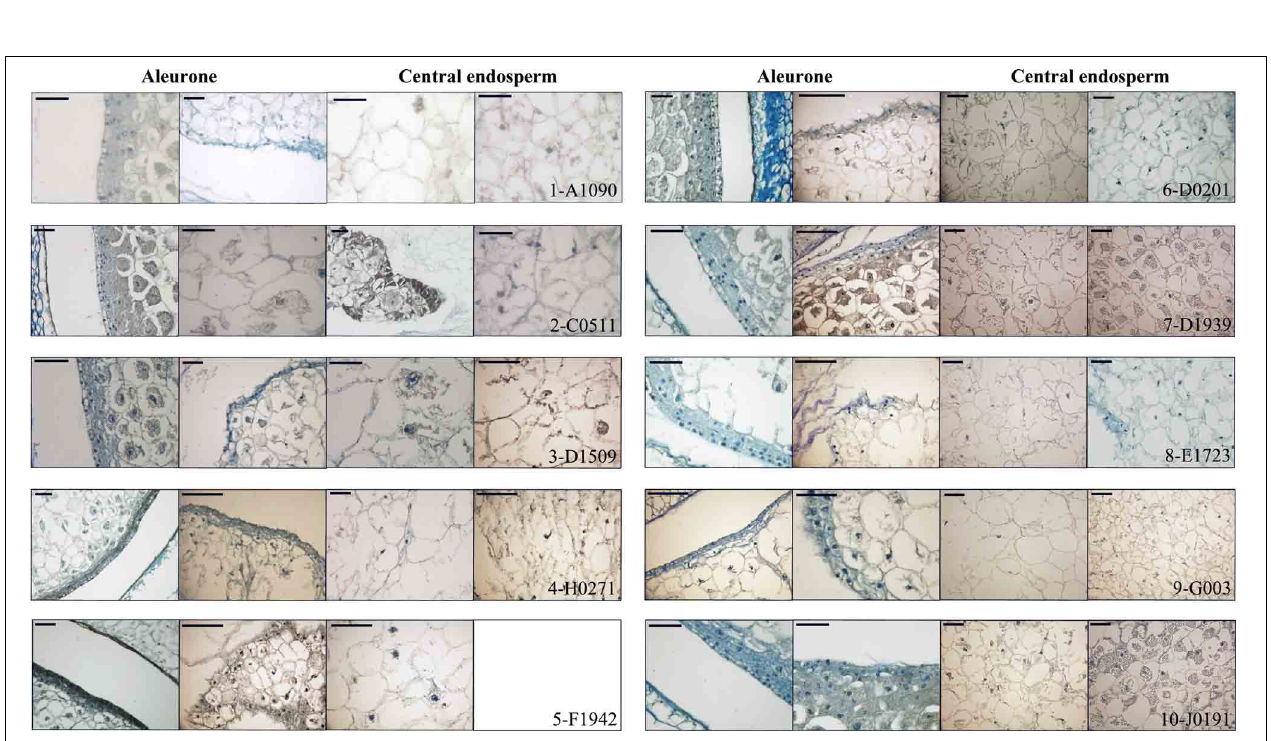
FIGURE 6 | Aleurone and central endosperm structure. Sections of WT (first and third column) and mutant (second and fourth column) 15 DAP kernels from each line are presented, showing magnifications of the aleurone and starchy endosperm cells. Sections are stained